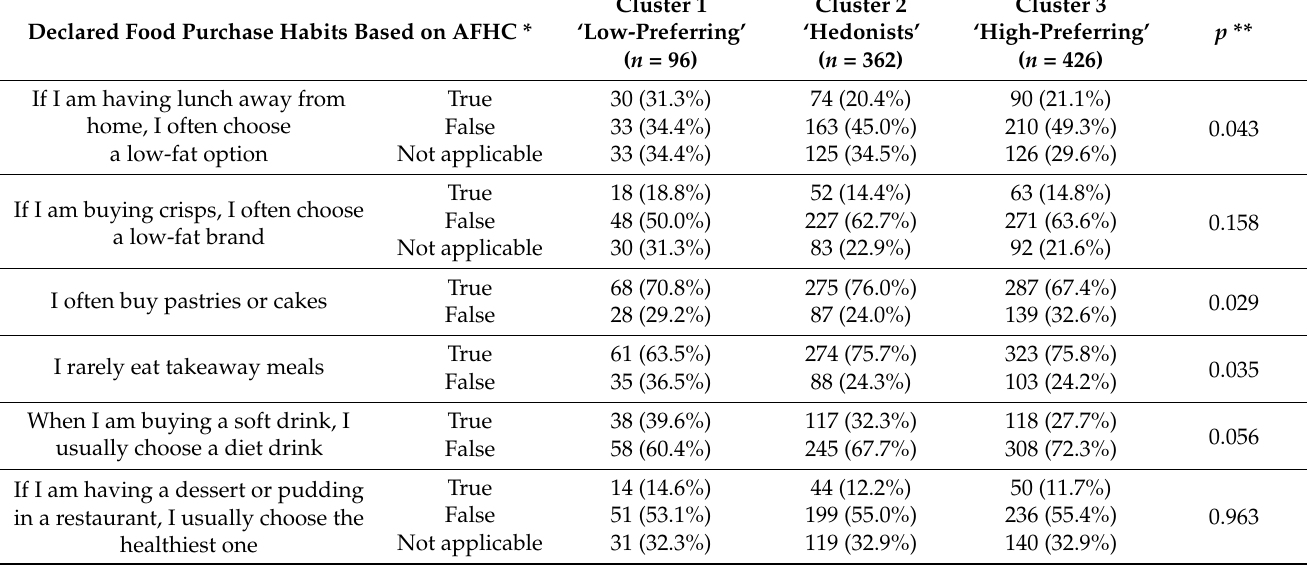
cluster, while the ‘high-preferring’ cluster did it more often than the ‘low-preferring’ cluster ( p = 0.006). Table 9. The declared food purchase habits assessed based on the Adolescents’ Food Habits Checklist (AFHC) in the clusters stratified based on the preferences assessed while using the Food Preference Questionnaire (FPQ) within the male population of the second phase of the Polish Adolescents’ COVID-19 Experience (PLACE-19) Study ( n = 884).